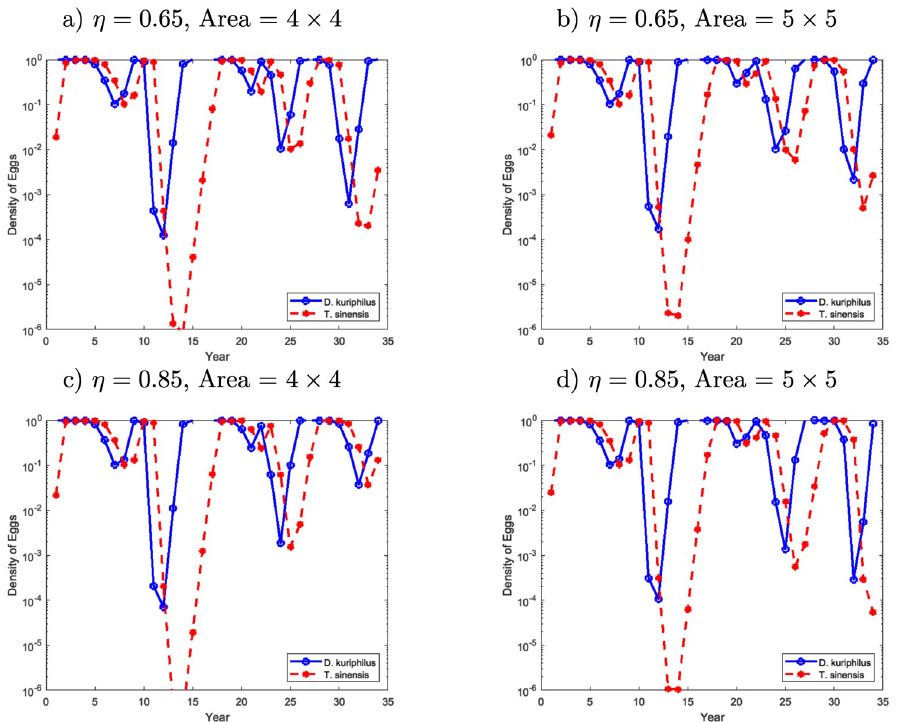
Fig 6. Egg density of D . kuriphilus ( v